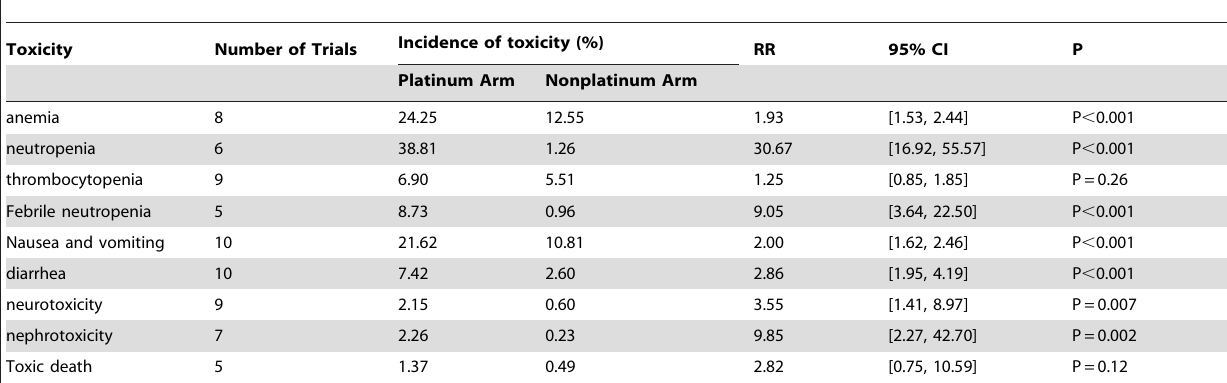
Table 1. Comparison of Toxicity between Platinum Arms and Nonplatinum Arms with old-generation